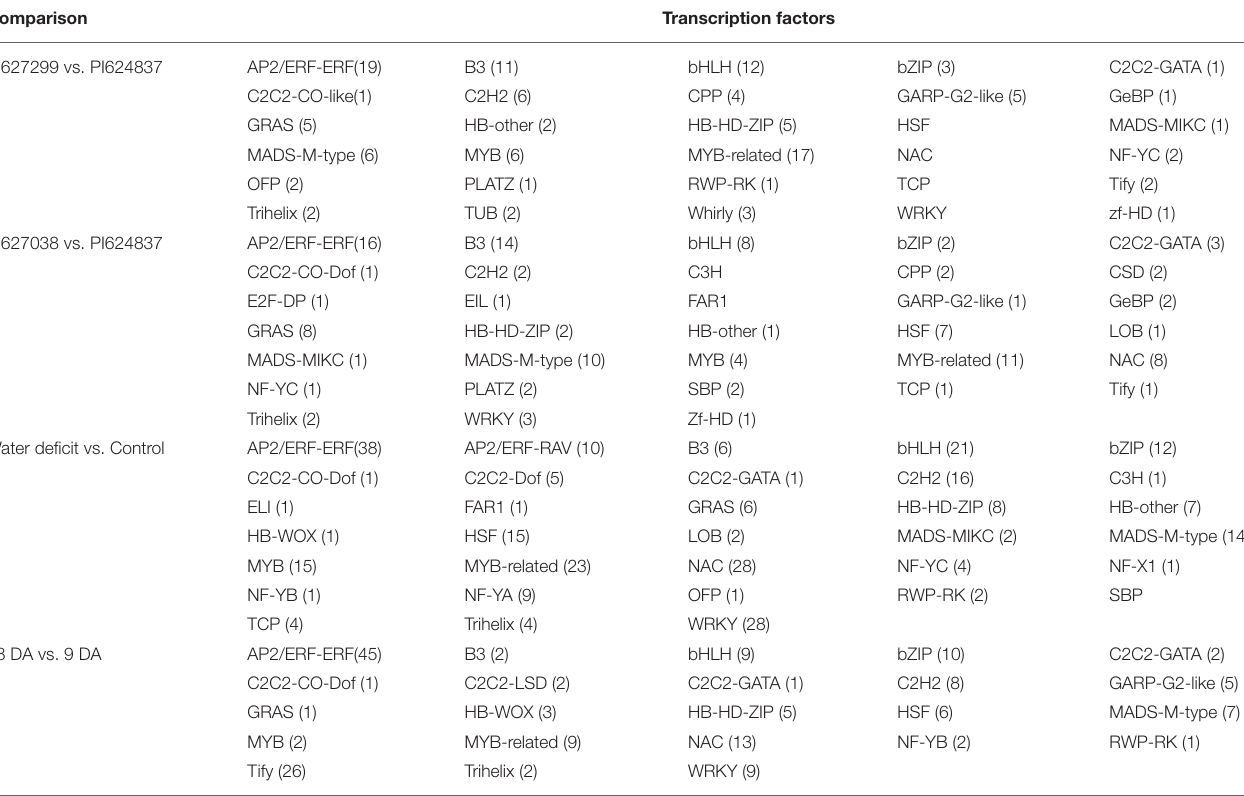
TABLE 2 | A summary of identified TFs among the different sets of DEGs in wheat.